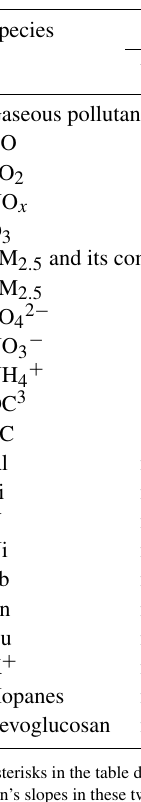
Table 3. Summary of the seasonal variation estimated by Sen’s